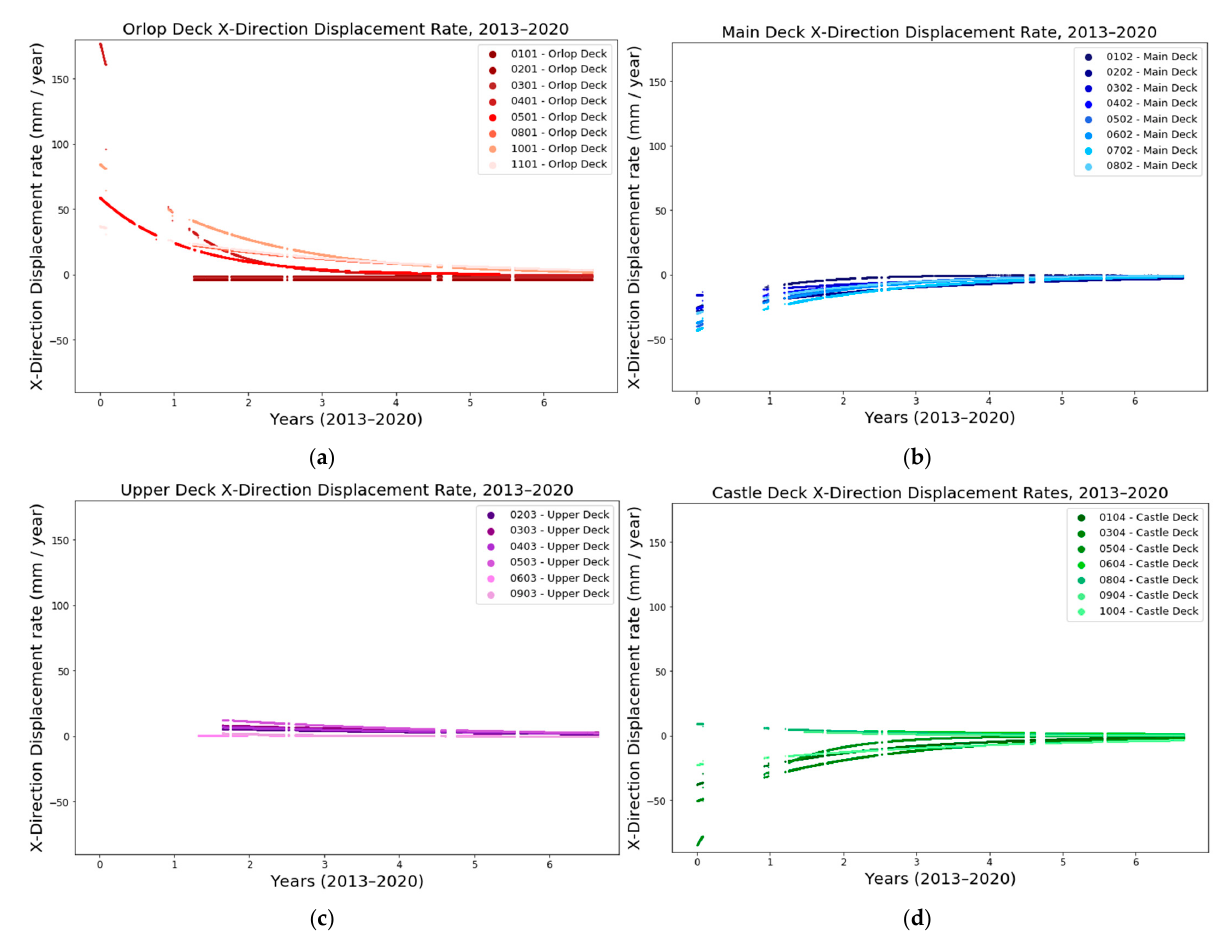
Figure 6. Rate of the X displacement of the TS targets in the ( a ) orlop, ( b ) main, ( c ) upper and ( d ) castle decks plotted against time for the period between September 2013 and March 2020.